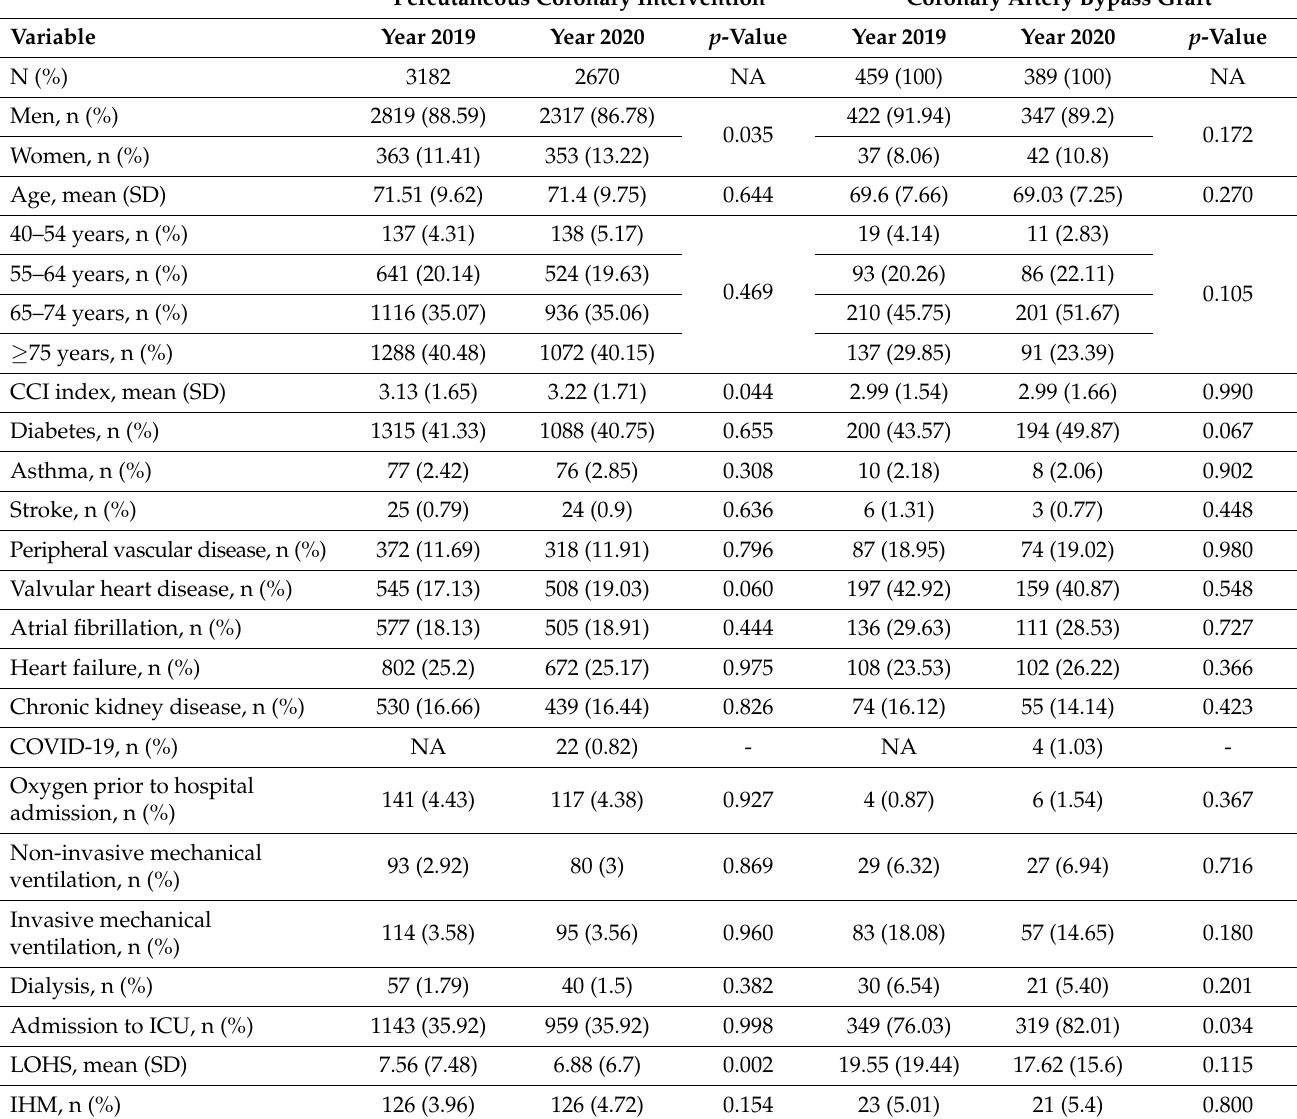
Table 2. Demographic and clinical characteristics and in-hospital outcomes of patients with chronic obstructive pulmonary disease who underwent a Percutaneous Coronary Intervention or a coronary artery bypass graft in Spain in 2019 and 2020. Analysis of the Spanish National Hospital Discharge Database. Percutaneous Coronary Intervention Coronary Artery Bypass